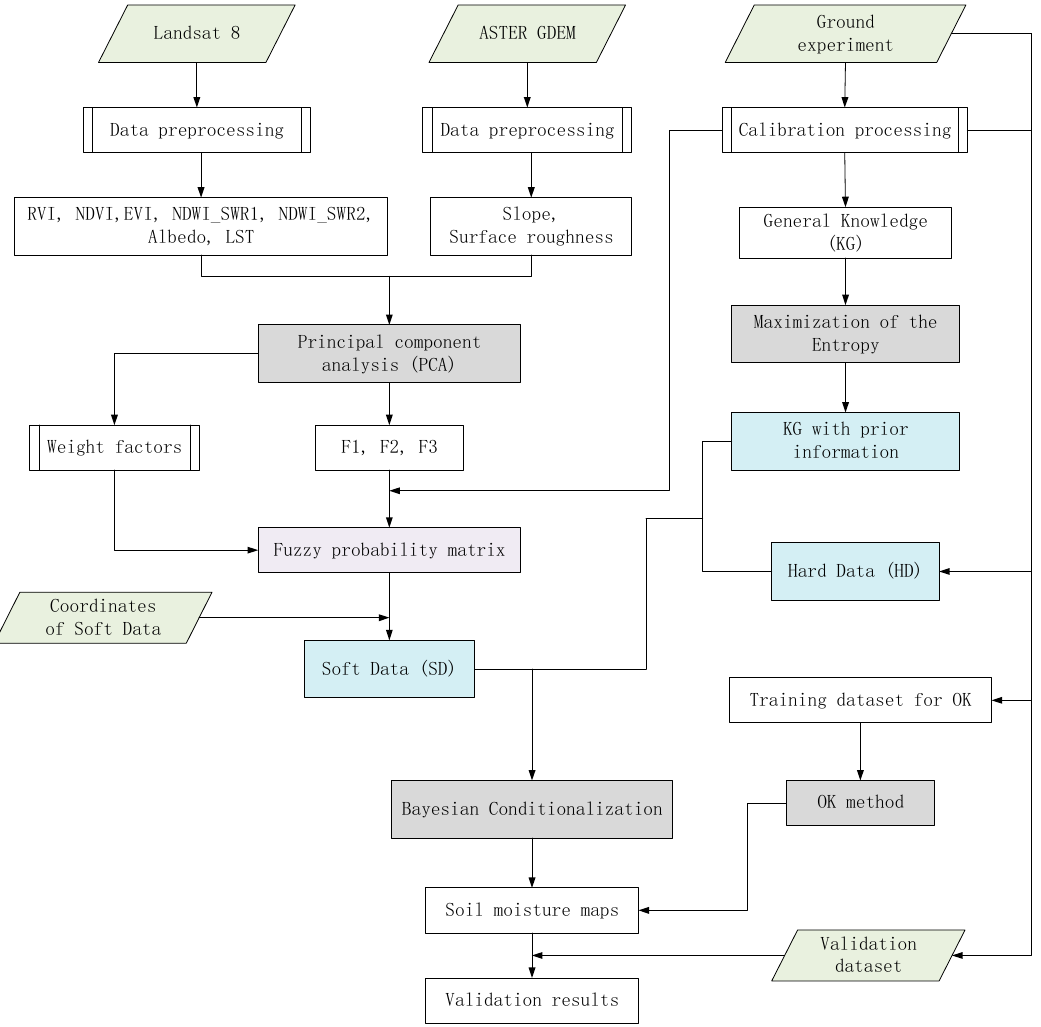
Figure 2. Flowchart of the proposed soil moisture mapping.